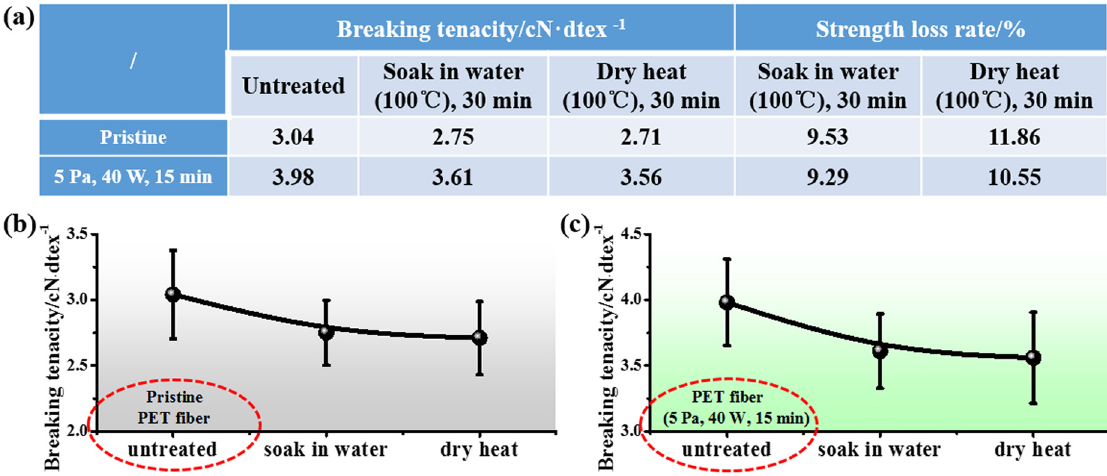
Figure 5: ( a ) Tensile data of PET fi bers under di ff erent treatment conditions; ( b and c ) comparison of the pristine PET and sputtered PET fi ber samples for di ff erent events, respectively.